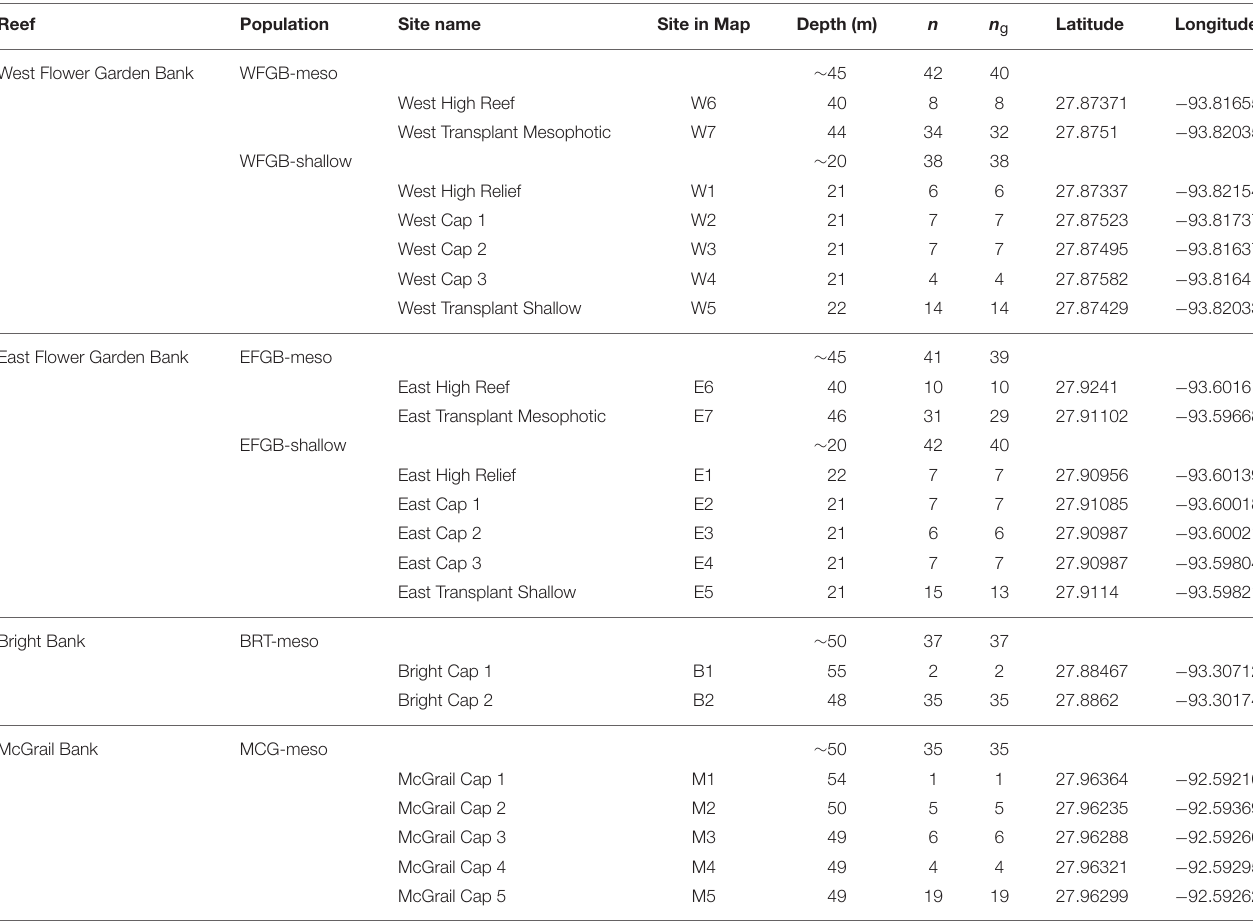
TABLE 1 | Montastraea cavernosa genotyped samples ( n = 252) collected across the northwest Gulf of Mexico, compared with the number of unique multi-locus genotypes (MLGs) shown as n g used for the analyses ( n g = 229).